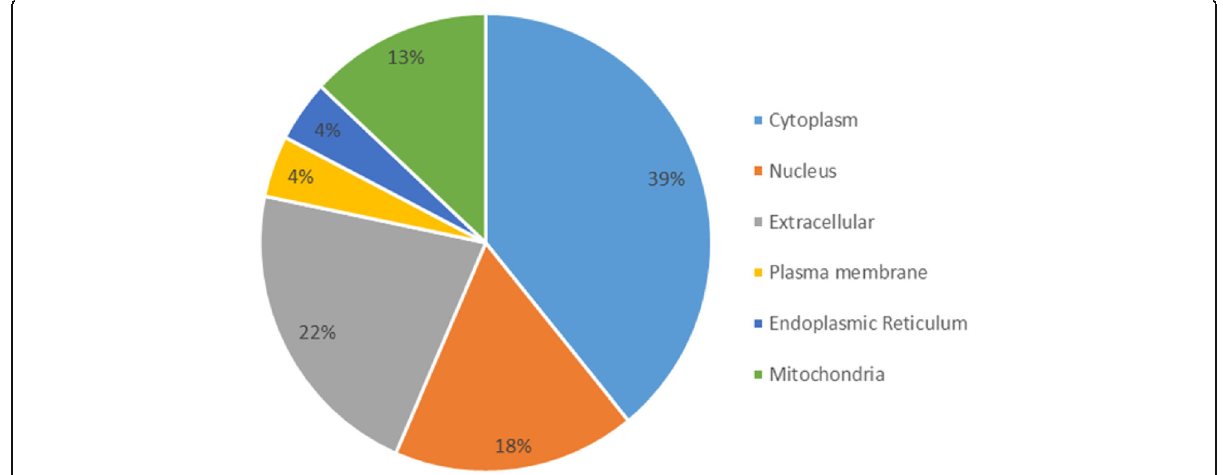
Fig. 1 Subcellular localization prediction using WOLFPsort web server of the 23 hypothetical proteins of P. falciparum